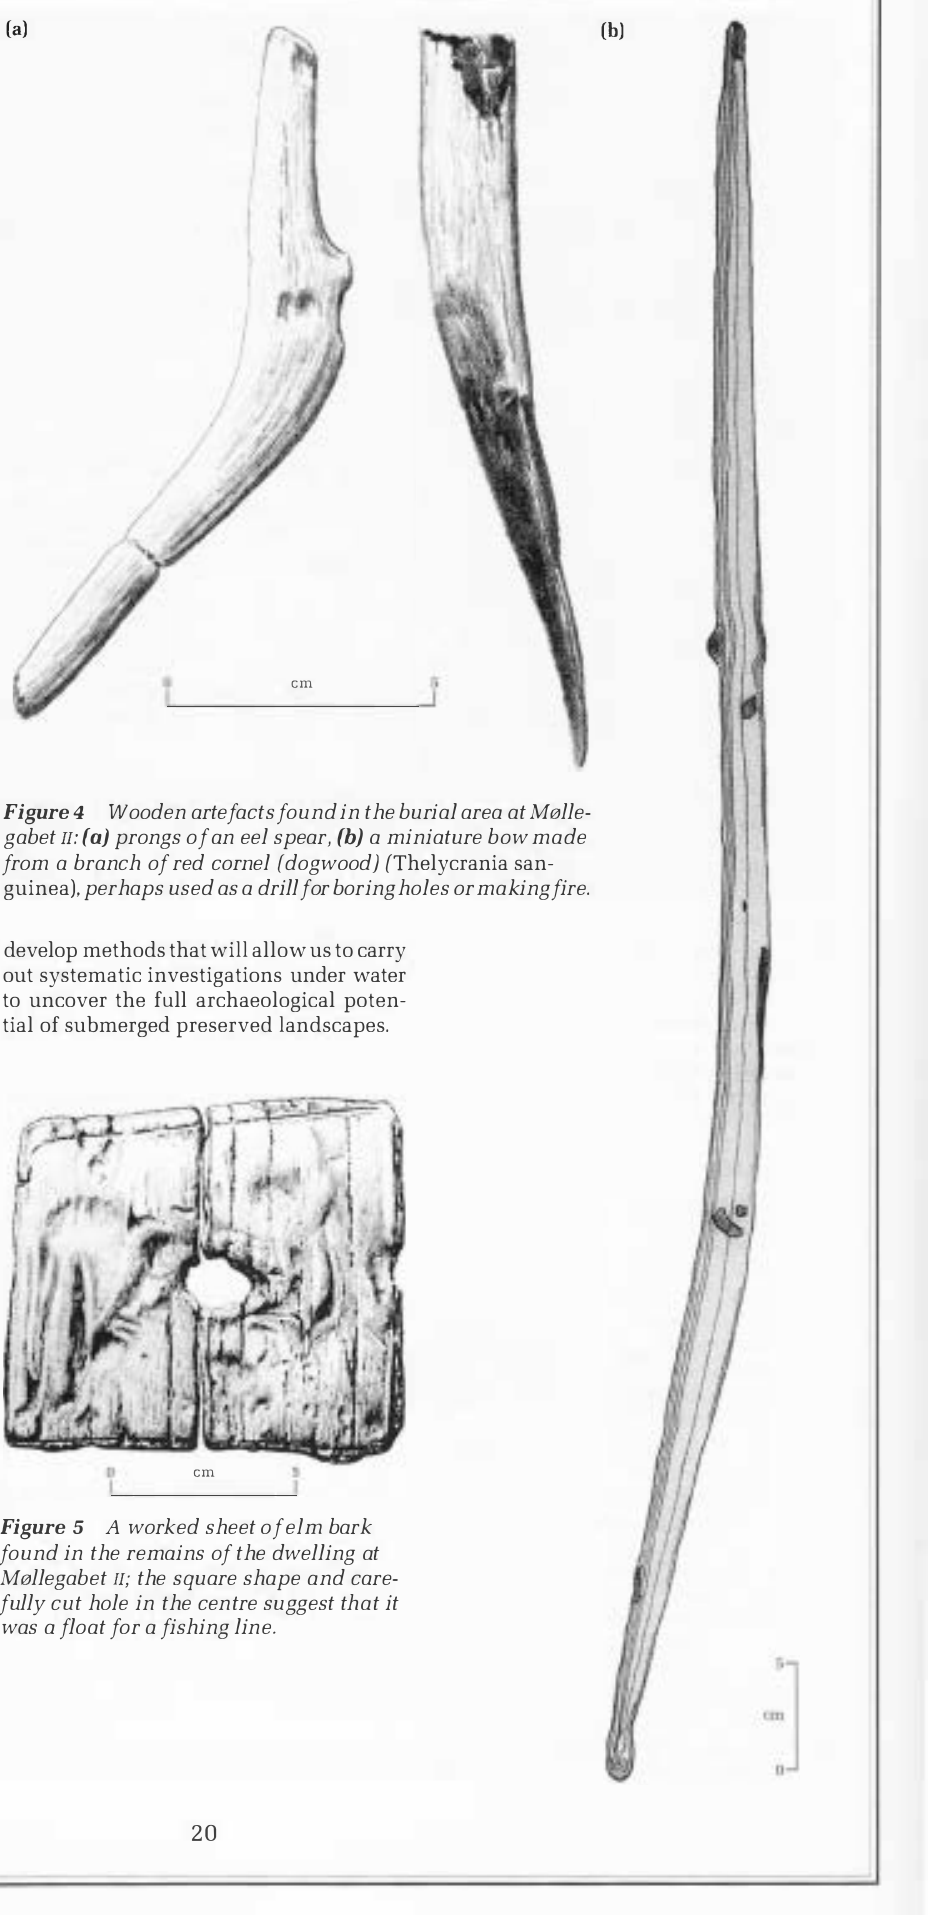
Figure 5 A worked sheet of elm bark found in the remains of the dwelling at Mollegabet II; the square shape and care­ fully cut hole in the centre suggest that it was a float for a fishing